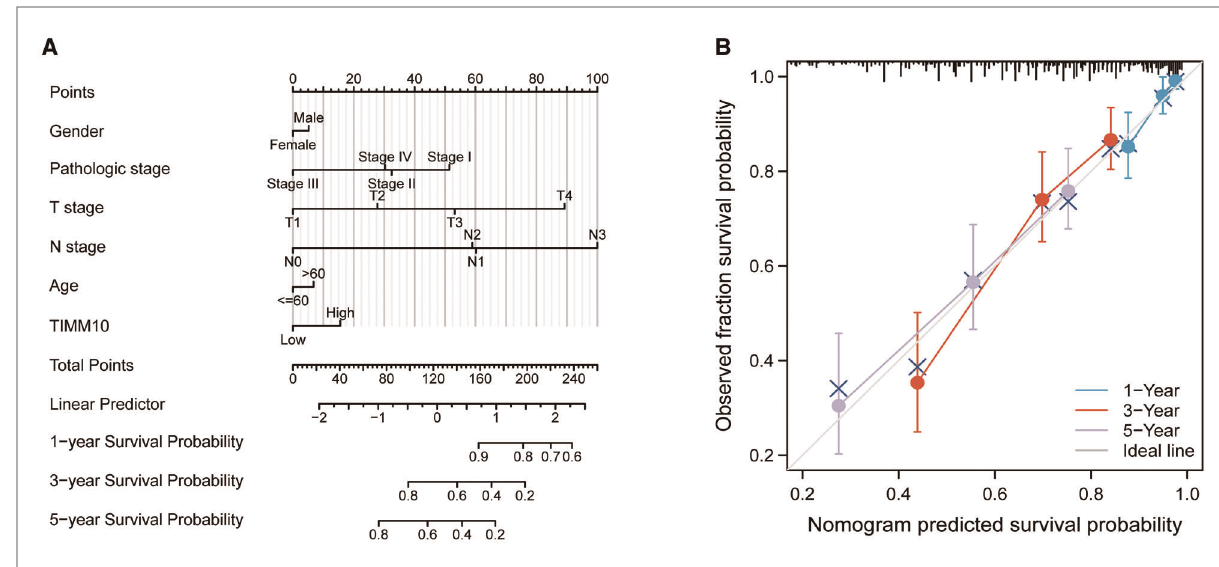
FIGURE 7 Nomogram model construction. ( A ) Nomogram. ( B ) Calibration plot.